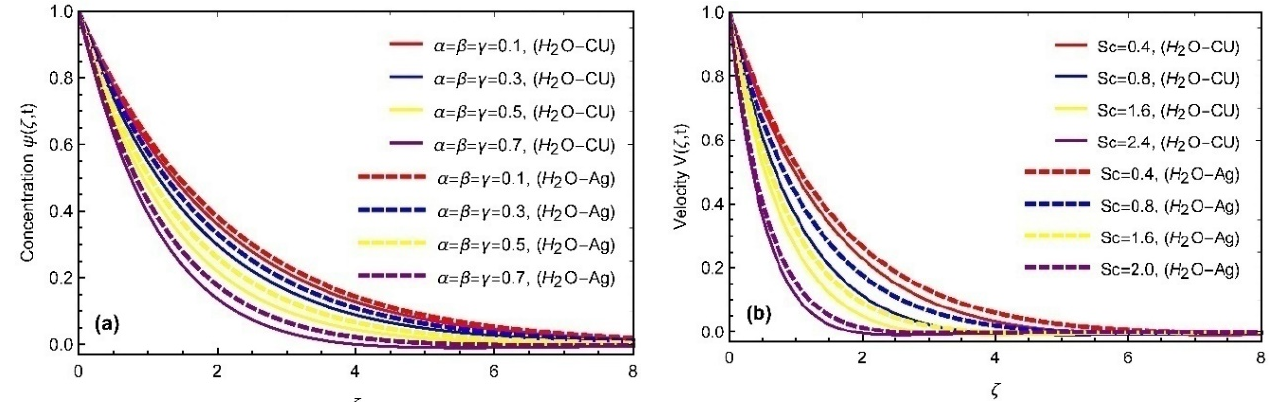
Figure 4. Concentration profiles for ( a ) α , β , γ and ( b ) Sc with ϕ = 0.02, t = 1.0.